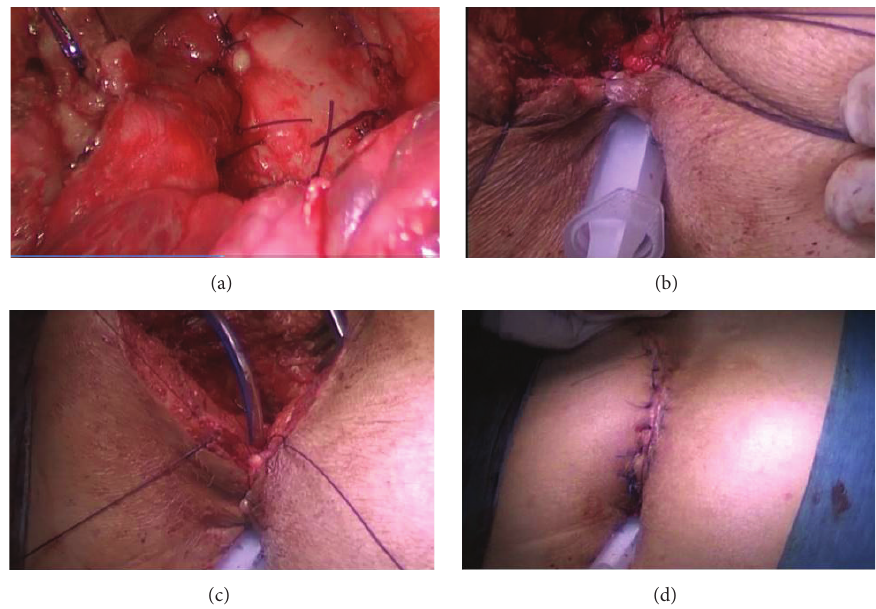
Figure 7: Pictures showing closure of posterior rectal wall and anal sphincter in an anatomical plane. (a) Closed RUF with rectal flap is seen. (b) Closed posterior rectal wall is seen. (c) Separately repaired anal sphincters by the guidance of suture which was placed at the beginning of operation. (d) Closed skin incision of the York Mason operation is seen.